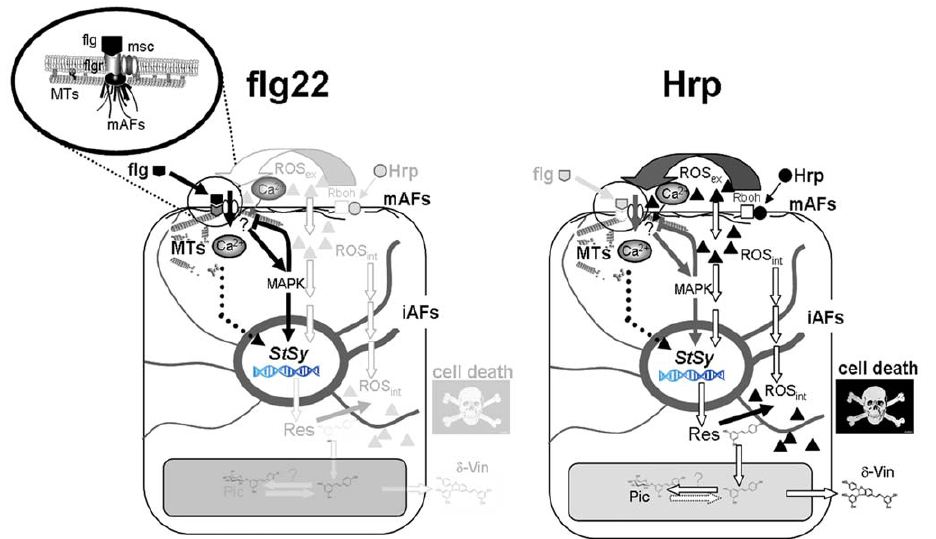
Figure 8. A simplified model for defence triggered by flg22 and Harpin in grapevine cells. Details are explained in the discussion. Flg , flg22; Hrp , bacterial protein Harpin; flgr , flg22 receptor (grapevine homologue of AtFLS2); msc , mechanosensitive ion channel; MTs , microtubules; mAFs , membrane-associated actin filaments; Rboh , grapevine homologue of NADPH dependent oxidase responsible for apoplastic oxidative burst ( ROS ex ) that can permeate the plasma membrane ( ROS int ); MAPK , MAPK-signalling pathway; StSy , stilbene synthase gene; iAFs , intracellular actin filaments; Res , trans -resveratrol; d -Vin , d -viniferin; Pic , trans